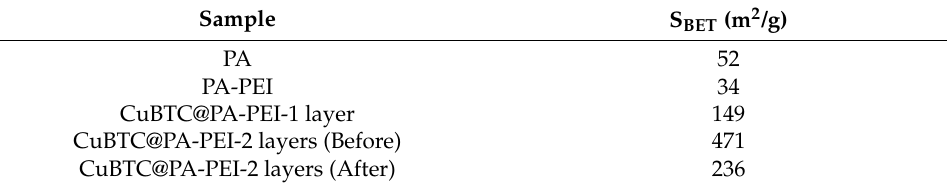
Table 1. S BET of the PA, PA-PEI, and CuBTC@PA-PEI samples before and after the CNCl exposure.